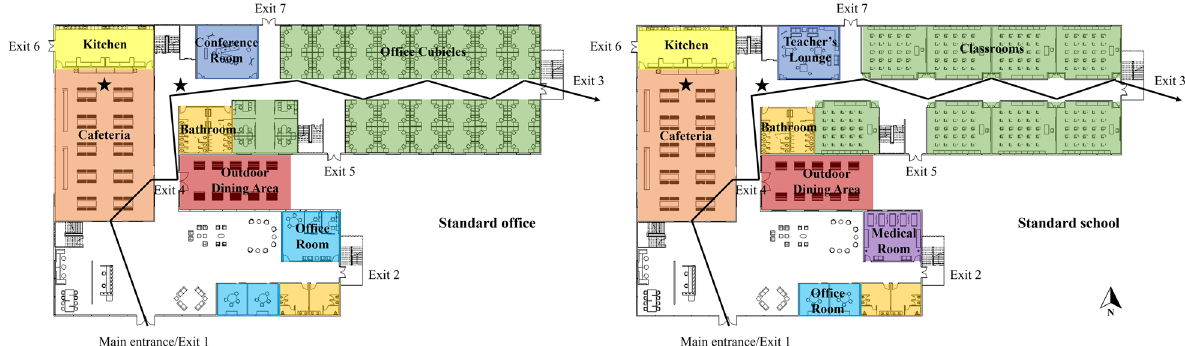
Figure 1. First-floor layouts of the standard office (left) and school (right). Stars denote participants’ starting locations: one in the cafeteria and one in the hallway. Arrowed lines denote the shooter’s movement